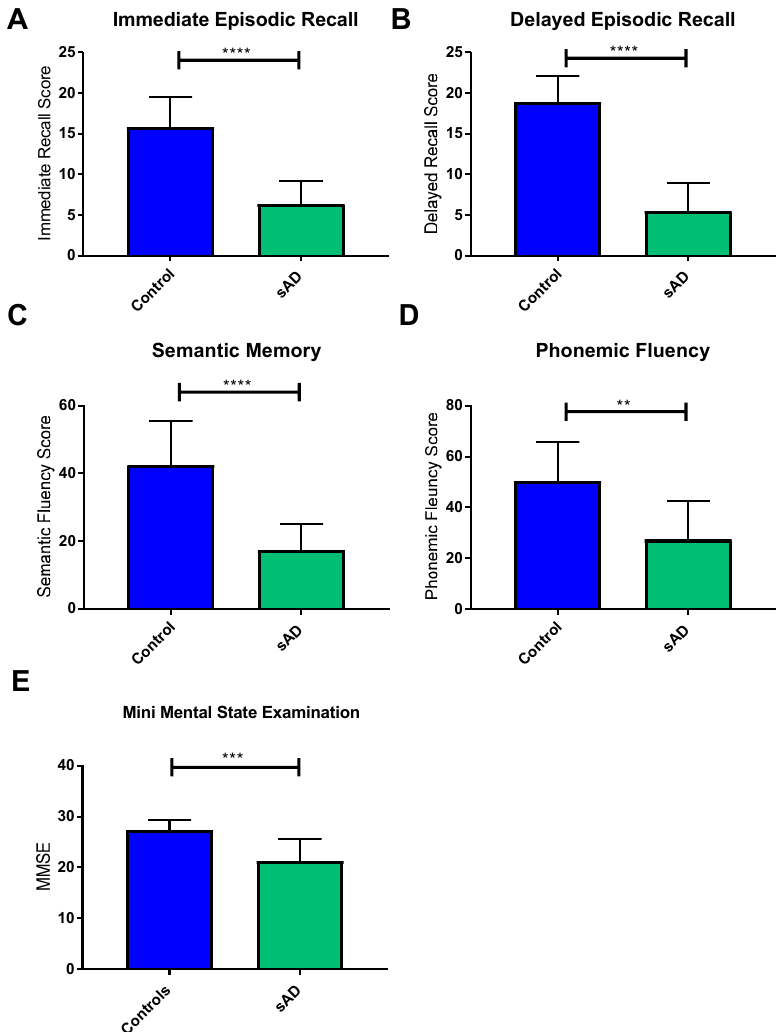
Figure 1. Mean scores of sporadic AD (sAD) patients and controls on cognitive tests included in the neuropsychological assessment. Graphs show mean with error bars indicating standard deviation. **** p < 0.0001; *** p < 0.001; ** p < 0.01. Controls are indicated by blue bars and sAD patients indicated by green bars. Significant reductions were seen in sAD immediate recall ( A ), delayed recall ( B ), semantic memory ( C ), phonemic fluency ( D ) and Mini Mental State Examination ( E ) when compared to